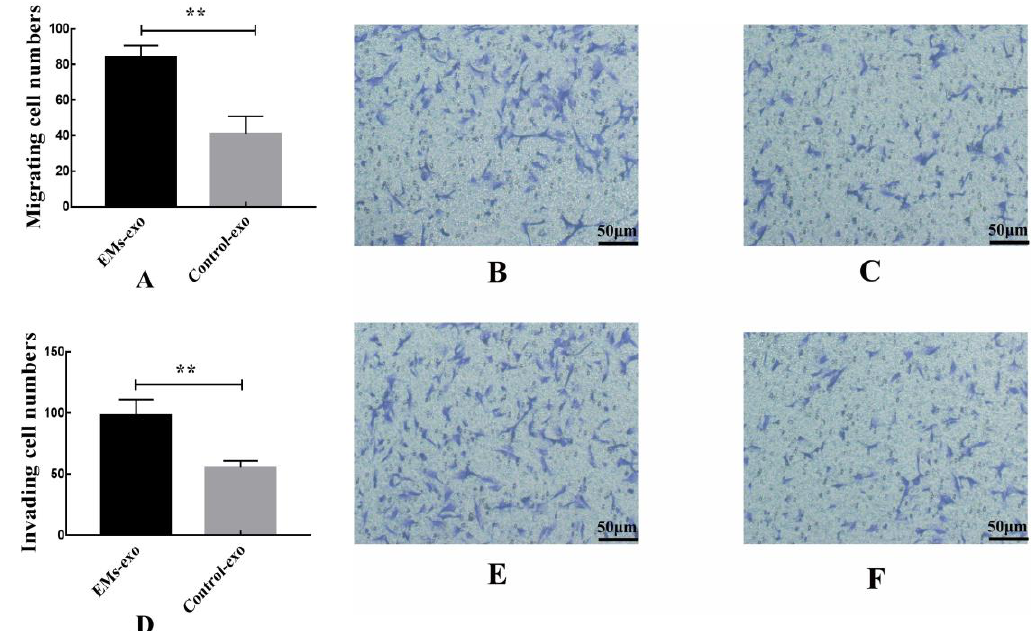
Figure 6. Exosomes from the EMs group could promote the migration and invasion of endometrial stromal cells by acting on macrophages. ( A ) The migration of endometrial stromal cells. ( B ) The effects of exosomes from the EMs group on the migration of endometrial stromal cells after acting on macrophages. ( C ) The effects of exosomes from the control group on the migration of endometrial stromal cells after acting on macrophages. ( D ) The invasion of endometrial stromal cells. ( E ) The effects of exosomes from the EMs group on the invasion of endometrial stromal cells after acting on macrophages. ( F ) The effects of exosomes from the control group on the invasion of endometrial stromal cells after acting on macrophages. Data are expressed as the mean ± SEM (** p < 0.01). Scale bar: 50 μm.